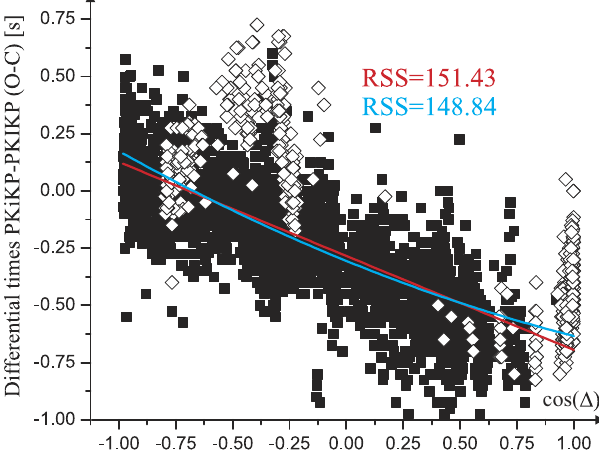
Figure 6. Differential times PKiKP-PKIKP vs. cosine of the angular distance of the PKIKP bouncing point to the (growth) G point (0, 80°W). The values of the Residual sum of Squares are indicated both for the linear (red, degree one spherical harmonic pattern, SHP) and the second order fit (blue, degree two SHP). The Akaike Criterion 42 is minimized by the quadratic fit in respect to the linear